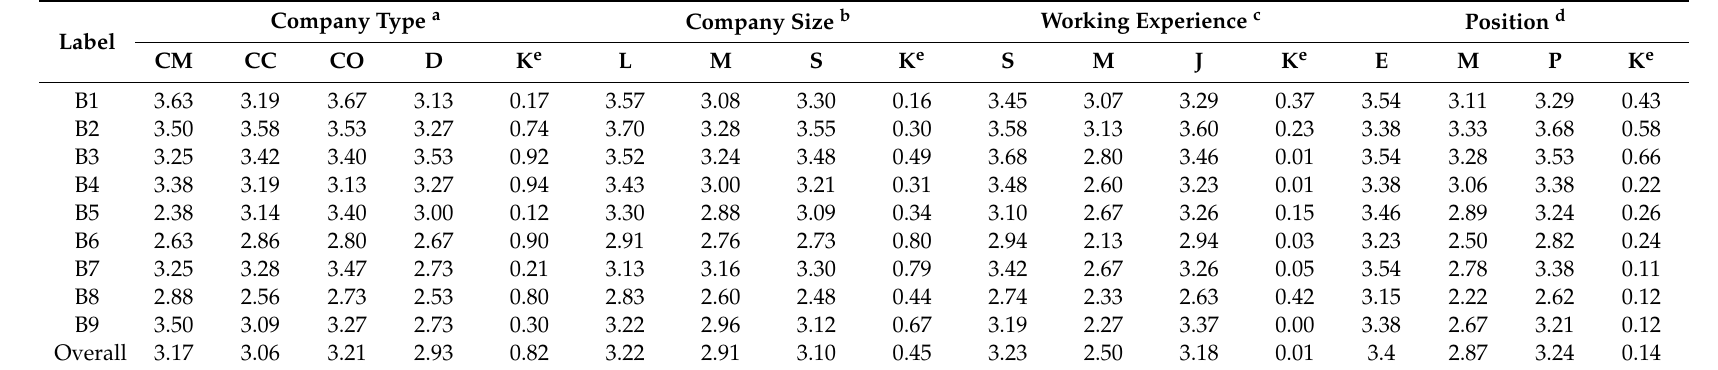
Table 6. Comparison of benefit variables between di ff erent groups of respondents.